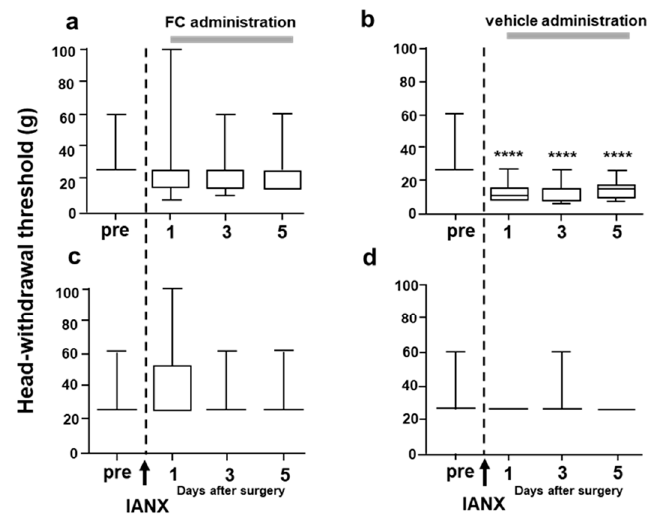
Figure 9. The effect of FC administration into TG on MHWT in IANX rats. ( a , b ): Ipsolateral side, ( c , d ): contralateral side. ( a , c ): IAN+FC, ( b , d ): IANX+vehicle. pre: before IANX. **** p < 0.0001 (pre vs. after). n = 7 in each group. Grey lines indicate the period treated FC and vehicle.